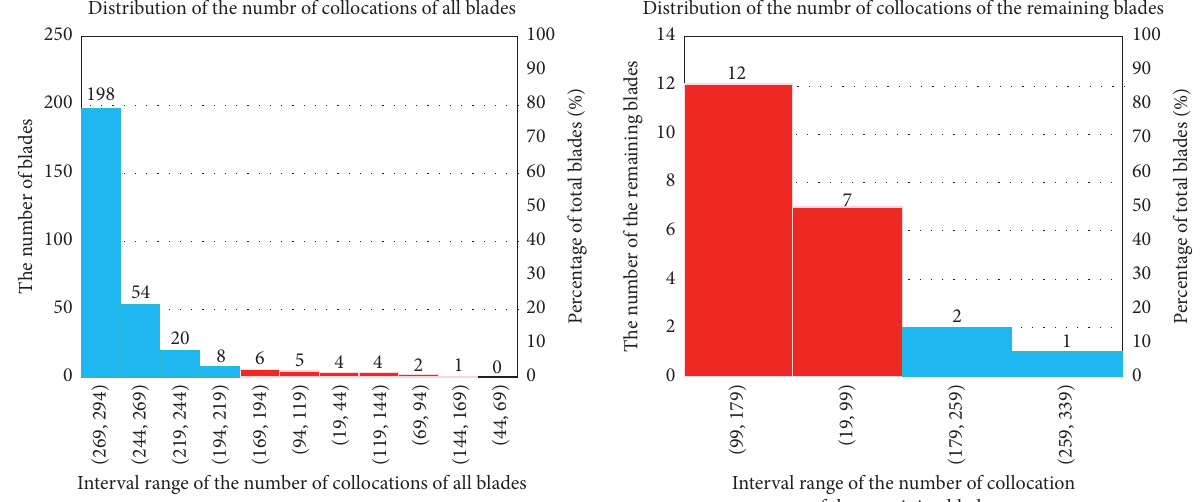
Figure 5: The distributions of the number of collocations of all the blades before selection and the remaining blades after